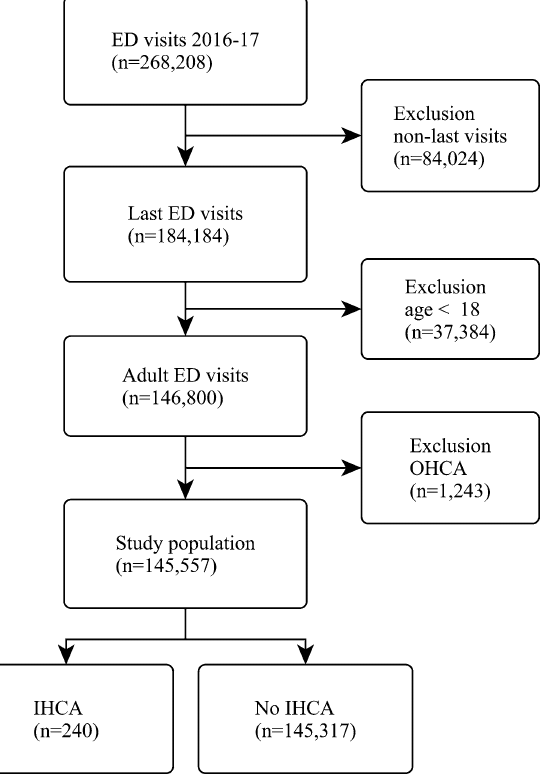
Figure 1. Flow diagram of the patient selection process. ED emergency department, IHCA in-hospital cardiac